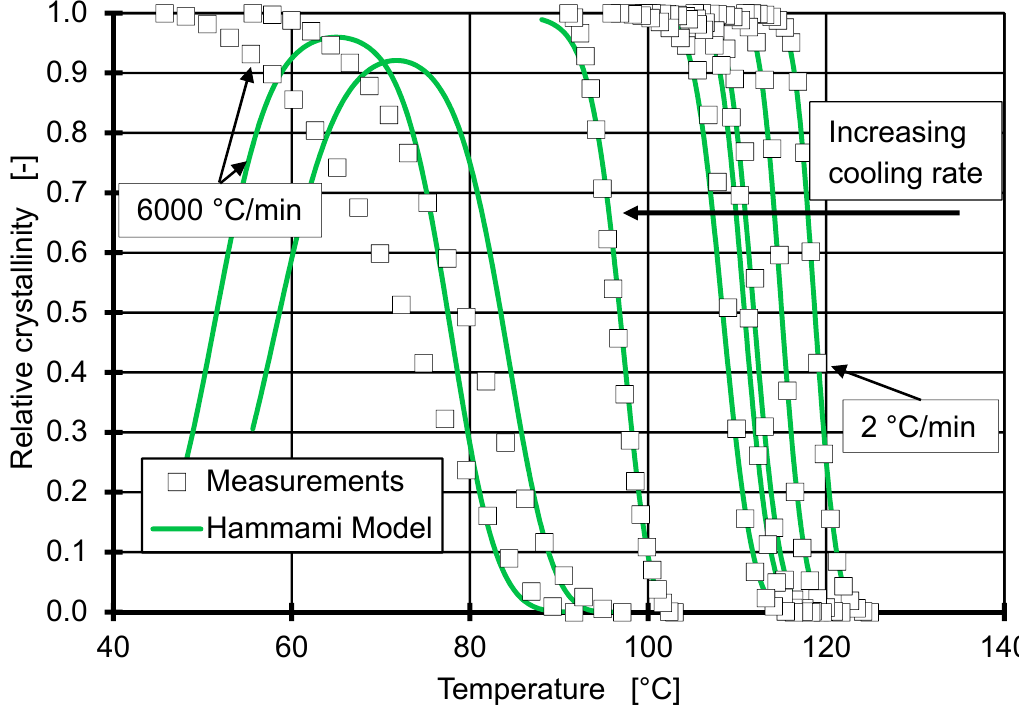
Figure 7. Hammami model using the individual fitted parameters for each cooling as mentioned in Table 2. The graph most to the left shows the crystallisation process for a cooling rate of 6000 °C/min, whereas the graph most to the right shows the crystallisation process for a cooling rate of 2 °C/min.